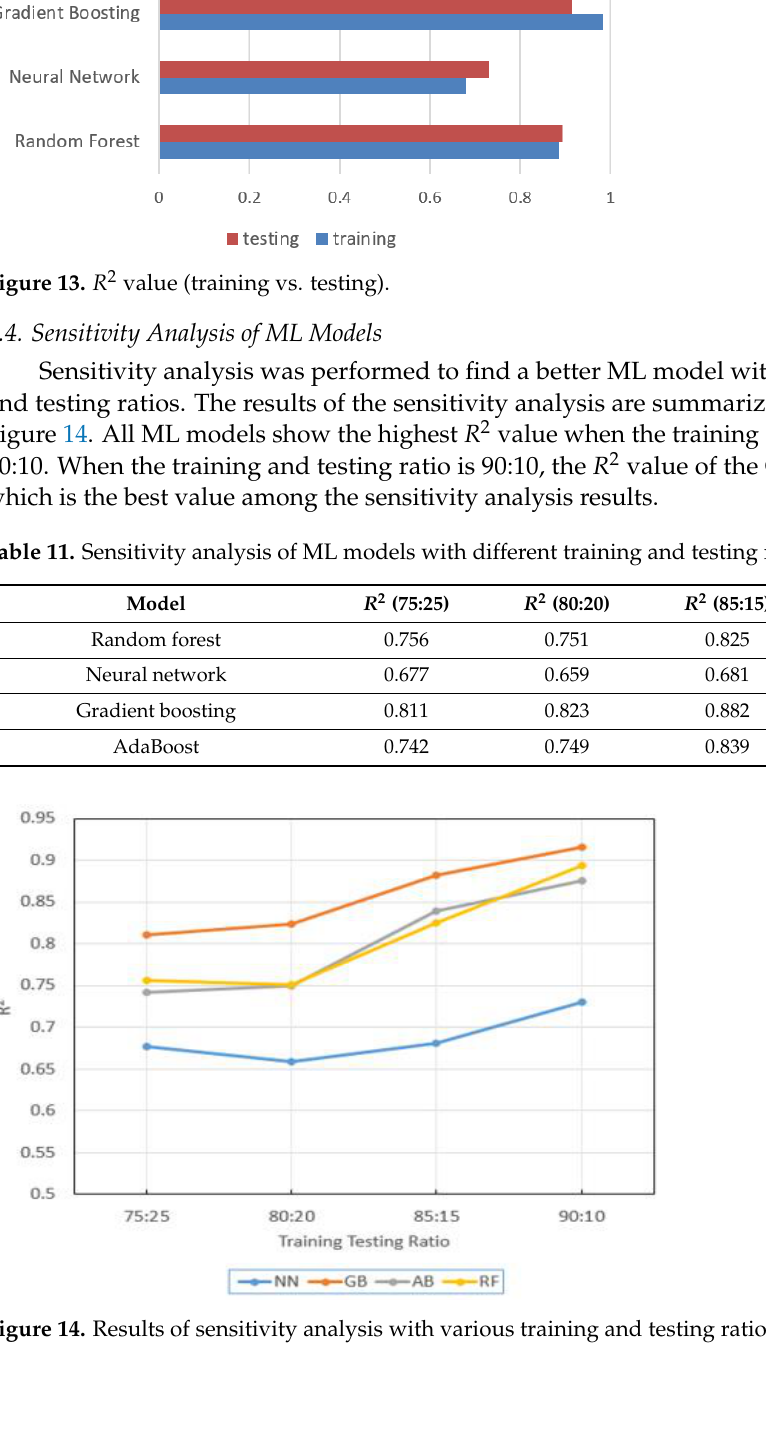
Figure 12 . Predicted vs observed data in model developed.